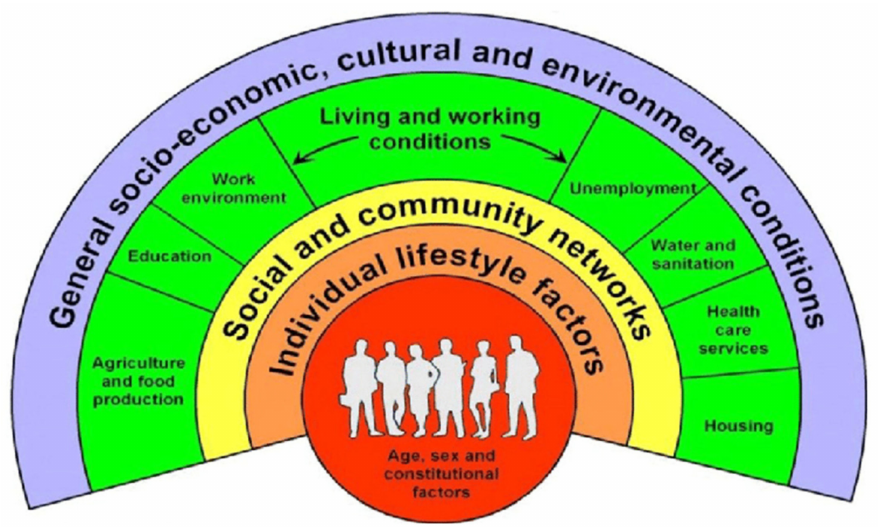
Figure 1. The main determinants of health. Reproduced with permission from Dahlgren, G. and Whitehead, M., European strategies for tackling social inequities in health; published by WHO,